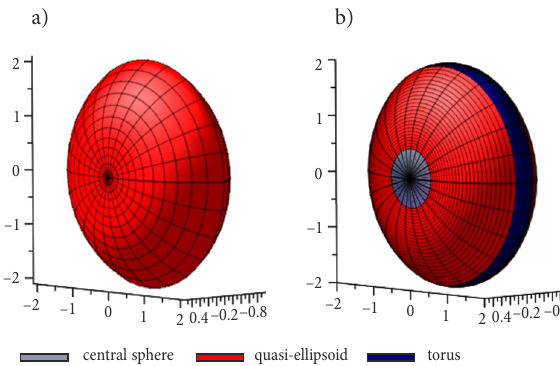
that proposed by Hale, see Zheng et al. (2013), where A and B are new variables determined from the local geometry (Johnson 1987).